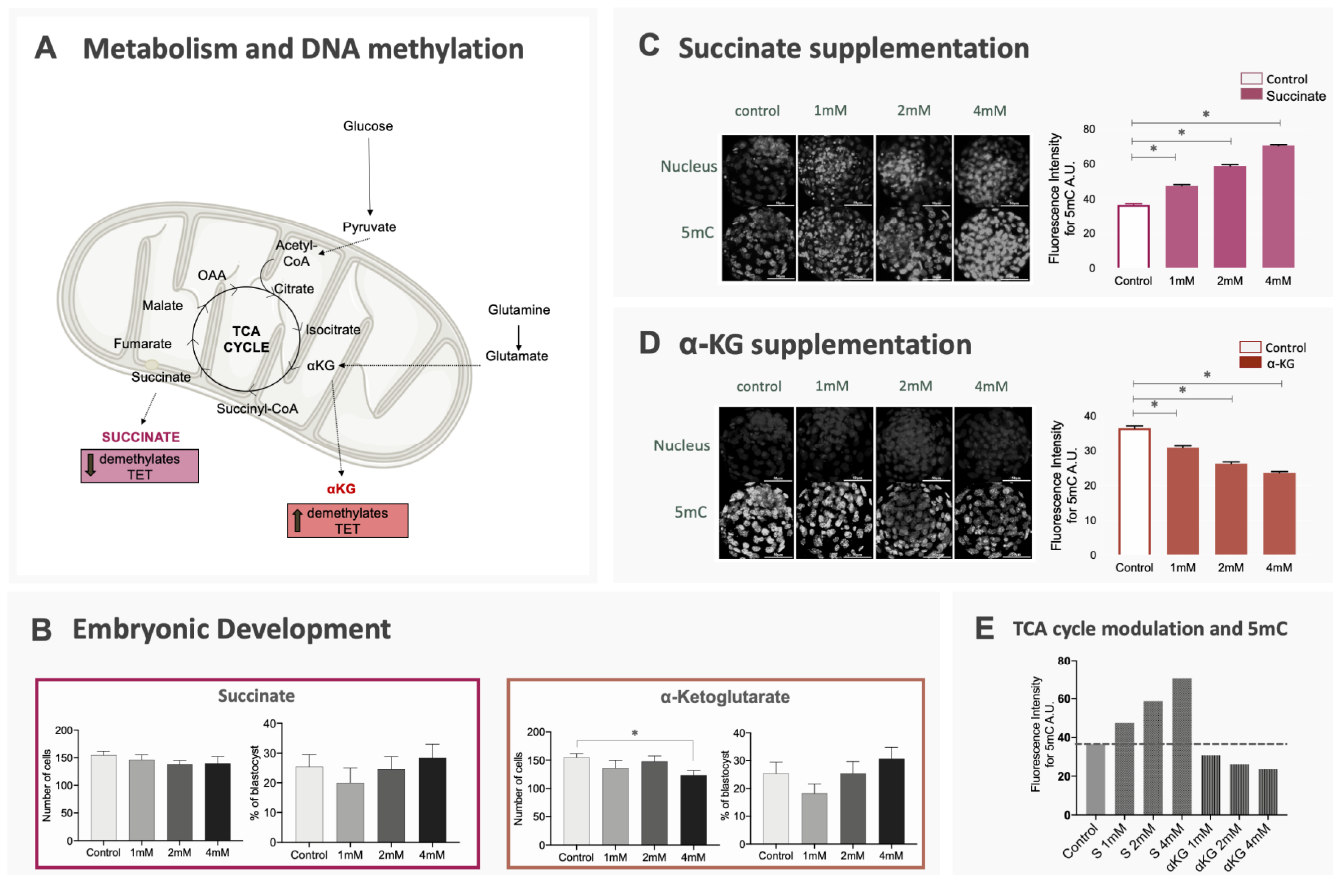
Figure 3 Figure 3. E ff ect of changes in the availability of α -KG and succinate on embryo development and DNA methylation. Bovine embryos were produced in vitro and culture in media supplemented with di ff erent doses of α -ketoglutarate, succinate or without supplementation (control). ( A ) TCA cycle and the relation between its metabolites and the activity of enzymes involved in DNA methylation; ( B ) blastocyst rates and total cell number of blastocysts for all groups. Data are represented as mean ± S.E.M; ( C , D ) 5mC immunostaining of blastocysts cultured in succinate or α -KG. Data are represented as mean ± S.E.M. For all comparisons described above, * represents statistical di ff erences; ( E ) representation of mean methylation levels in blastocysts for each experimental group compared to